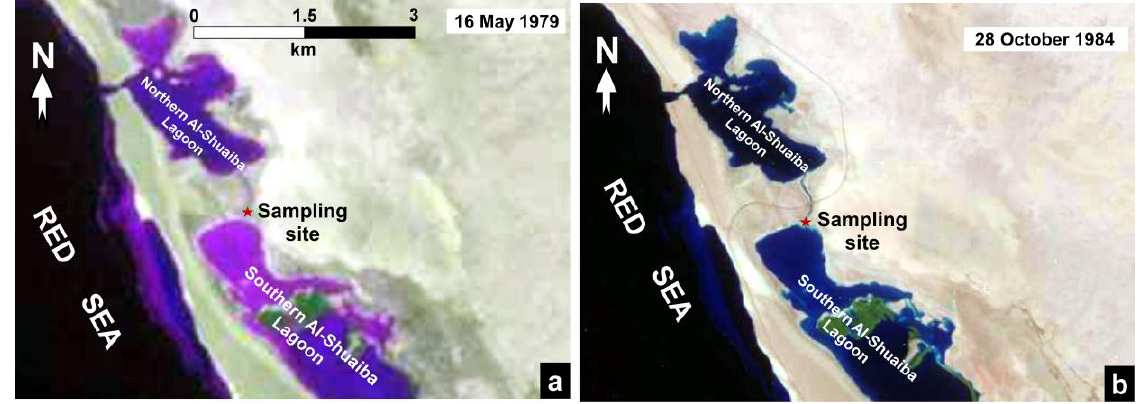
Figure 2. Historic land-sat images of Al-Shuaiba area showing the evolution of the area before ( a ) and after the road construction ( b ) between the two lagoons .